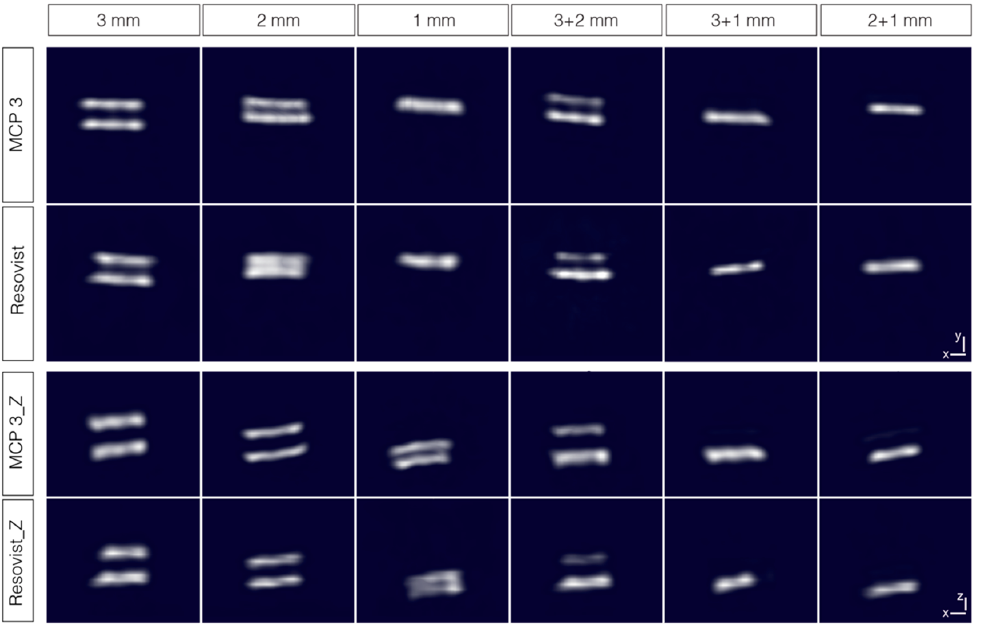
Figure 10. Dual-tube phantoms combining tubes of identical and different inner diameters (of 1, 2, and 3 mm) with MCP 3 and Resovist ® at 10 mmol Fe/l and measured in two orientations. Images are interpolated and represented as maximum intensity projections with the threshold set at 50%. Nanomaterials 2019 , 9 , x FOR PEER REVIEW